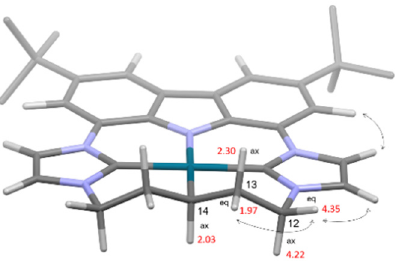
Figure 5. DFT (BP86/def2-TZVP)-optimized structure of [Pd(bimca C5H9 )] ( 6 ), showing the chemical shifts of methylene and methine signals (red) and important NOE cross peaks (black arrow).